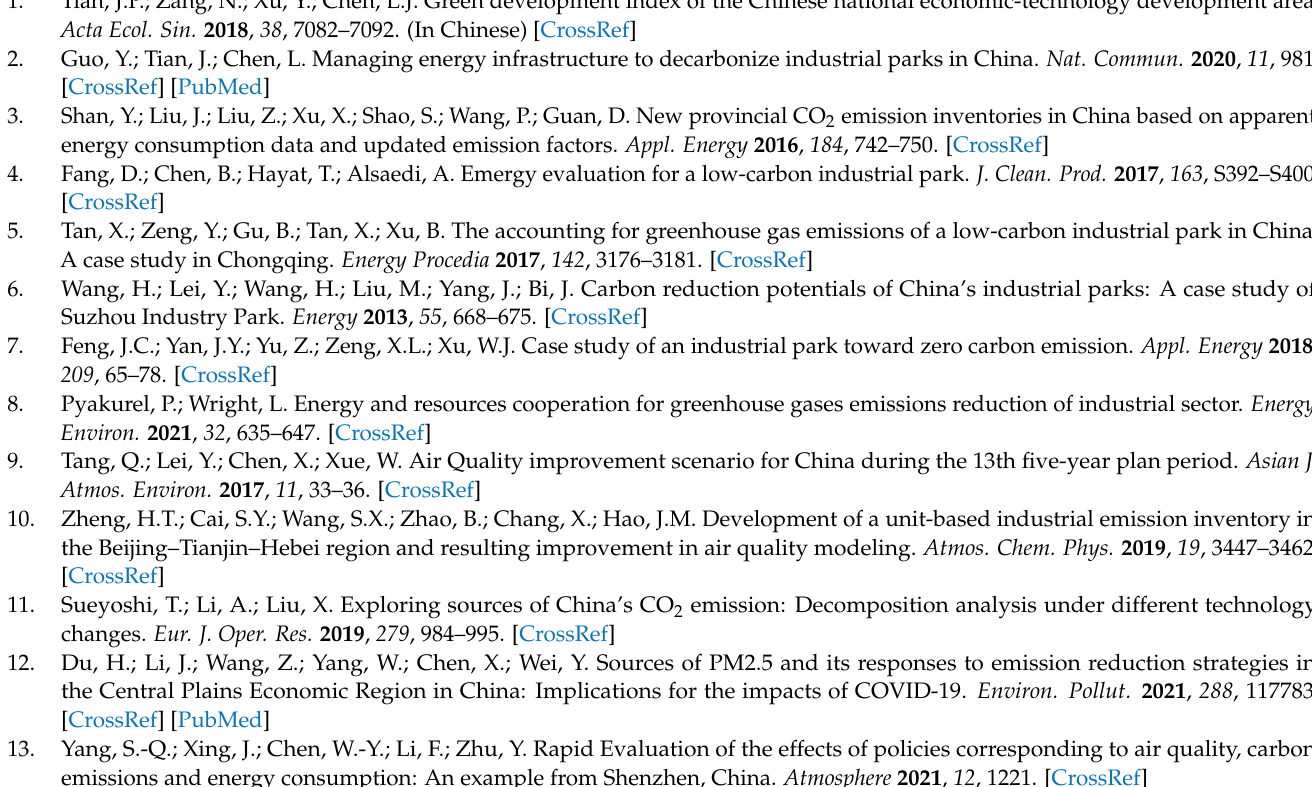
Table S3: Industry process emission factors (g/kg-product or raw material). Table S4: Related pa- rameters of PM X emission factors for coal-fired boilers. Table S5: CO 2 emission factors and related parameters. Table S6: Energy saving of 11 energy efficiency technologies in coal-fired power plants. Table S7: The removal efficiency under different end treatment and CCS technologies. Table S8: Spe- cific parameter setting of WRF simulation. Table S9: Specific parameter setting of CMAQ simulation. Table S10: Emission inventory of air pollutants (t). Table S11: Emission inventory of CO 2 (10 4 t). All information is mentioned in [51–71] here in the text and Supplementary Materials